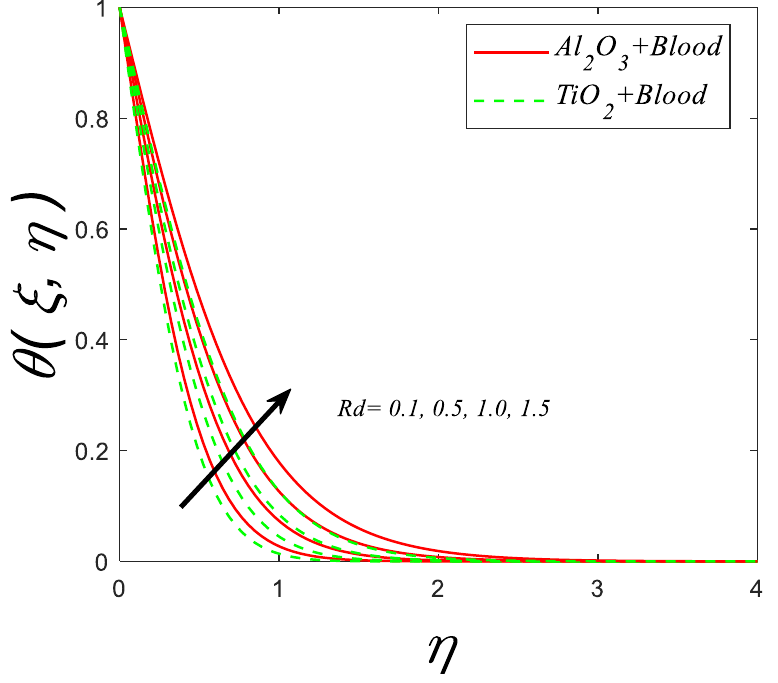
,𝑀 = 0.3,𝜉 = , M = 0.3, ξ = 0.1, 3 3